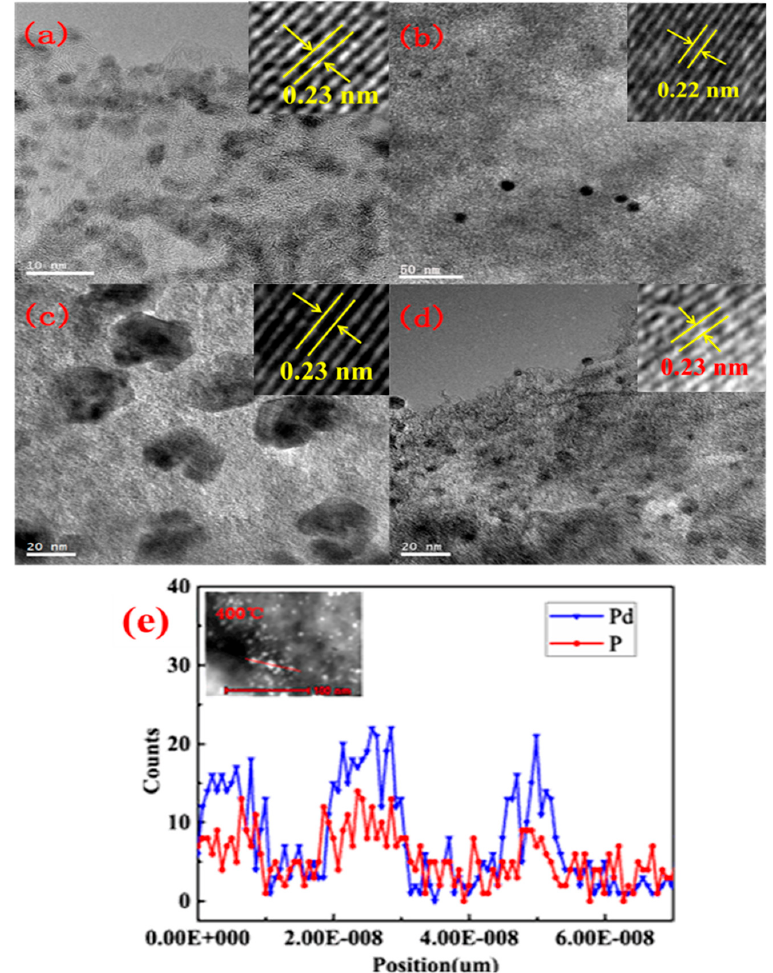
Figure 3. Transmission electron microscopy (TEM) images of Pd-P/C catalysts treated with different addition amounts of hypophosphite and PdO/C. ( a ) PdO/C; ( b ) Pd-P(0)/C(400); ( c ) Pd-P(8)/C(400); ( d ) Pd-P(32)/C(400); ( e ) element line scan of Pd and P of